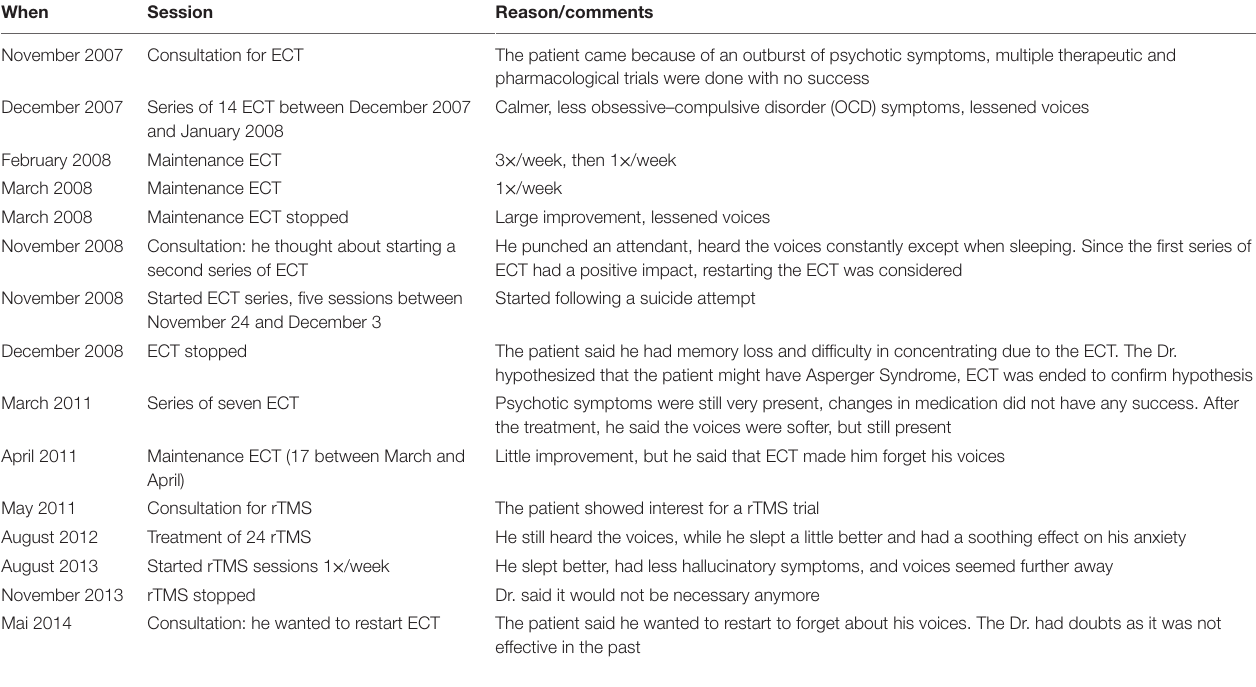
tabLe 2 | Electroconvulsive therapy (ECT) and repetitive Transcranial magnetic stimulation (rTMS) sessions. When session